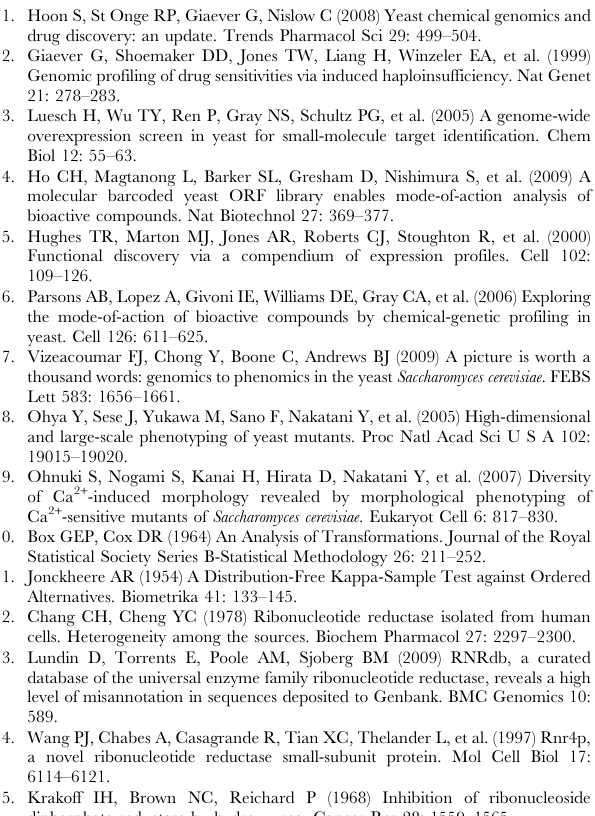
Table S7 A list of parameters identified from echinocandin B-treated cells using Jonckheere-Terpstra tests at FDR = 0.01. The color scheme is the same as Table S1. A) A list of parameters detected at stage A (unbudded cells with one nucleus). B) A list of parameters detected at stage A1B (budded cells with one nucleus).